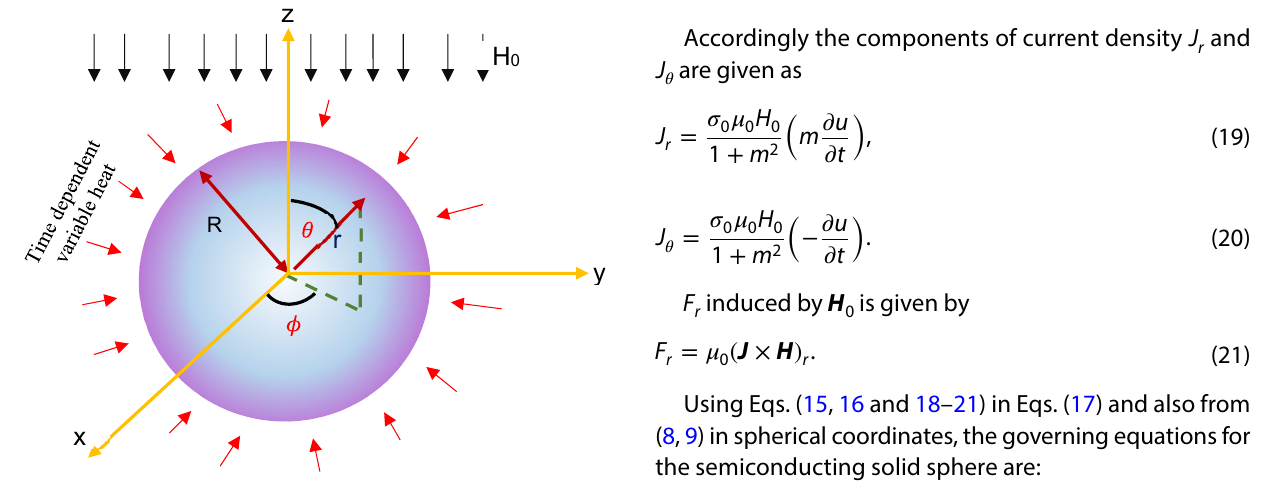
Fig. 1 Schematic diagram of semiconducting solid